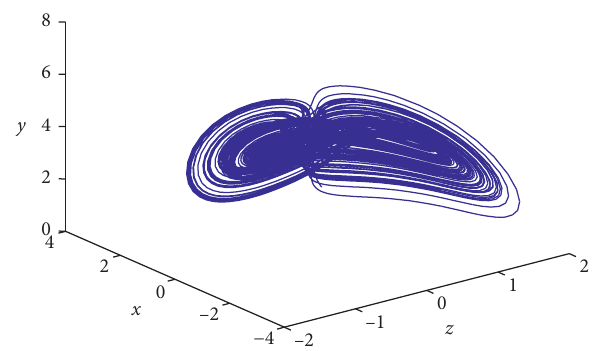
Figure 1: Chaotic attractor for the 3D chaotic system